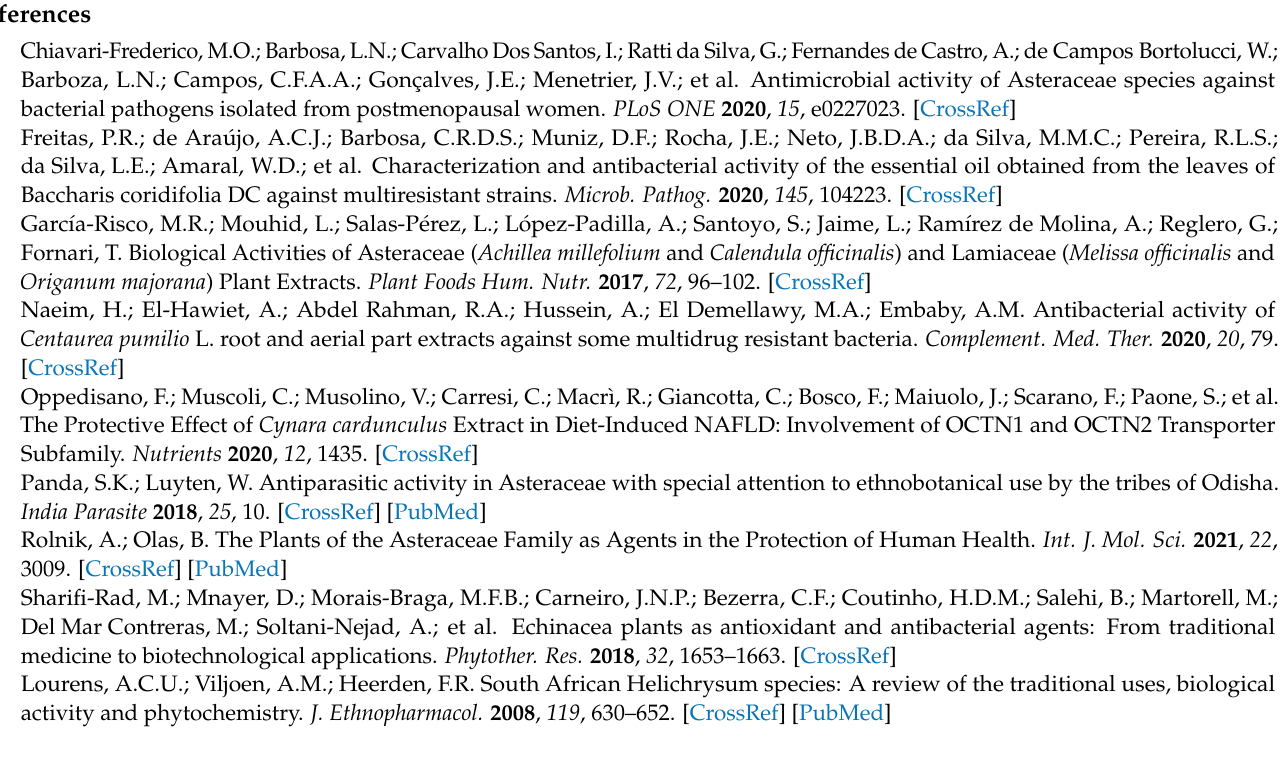
carbon-13 ( 13 CNMR) spectrum of CF6 . Figure S3: Correlation spectroscopy (COSY) spectrum of CF6 . Figure S4: Attached proton test (ATP) spectrum of CF6 . Figure S5: Heteronuclear Single Quantum Coherence (HSQC) spectrum of CF6 . Figure S6: Heteronuclear multiple bond correlation (HMBC) spectrum of CF6 and Figure S7: High resolution electrospray ionization mass spectrometry (HRESIMS) spectrum of CF6